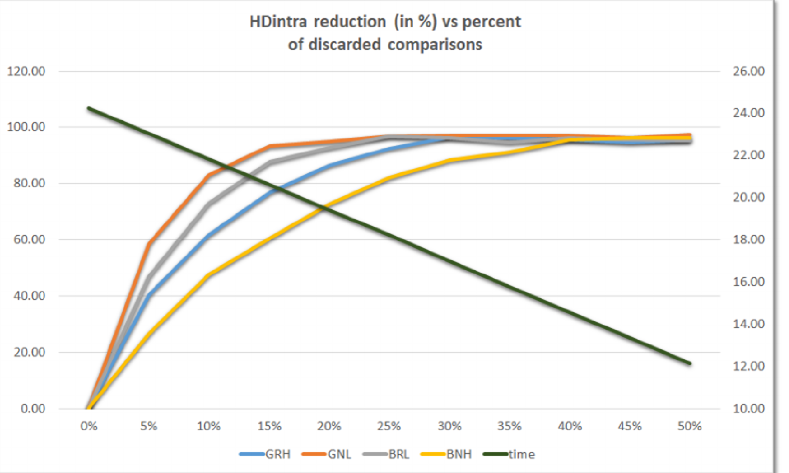
Figure 11. Reduction of HDintra and operation time as a function of the percentage of challenges